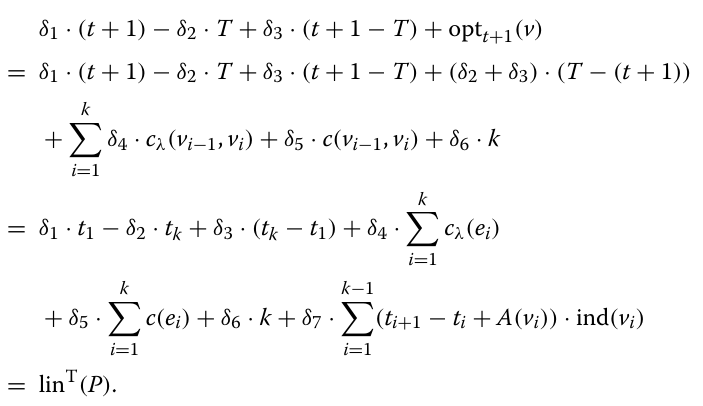
Algorithm 1 finds in modDijkstra the path P (cid:8) , adds ( opt updates opt ( v ) to the minimum of opt ( v )